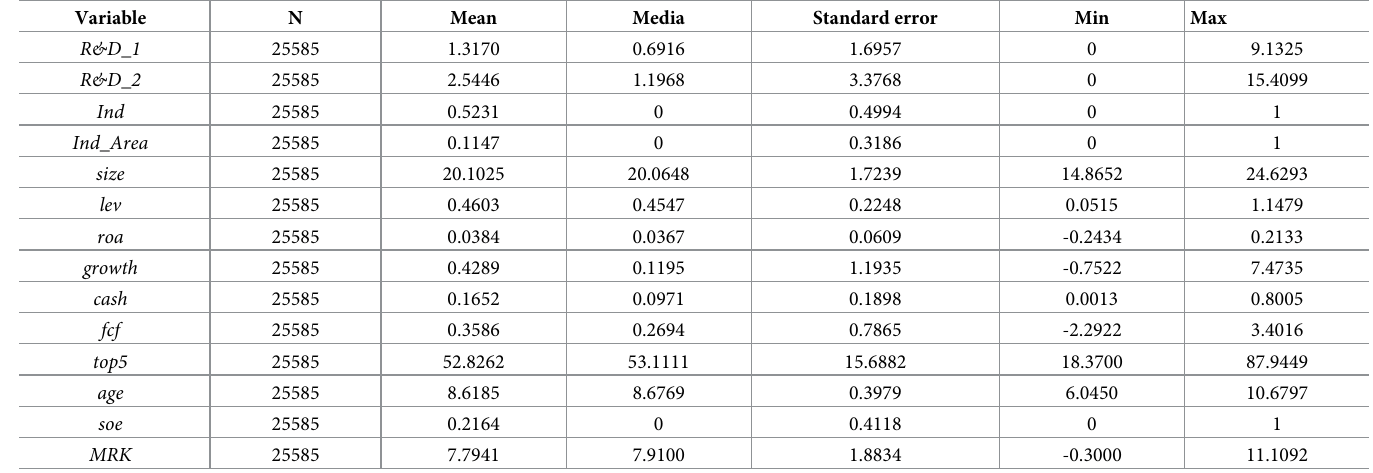
Table 3. Description of the